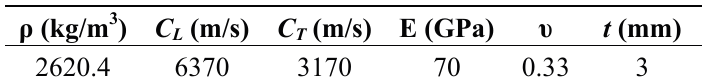
Table 1. Material properties of the plate model: Mass density ( ρ ), longitudinal wave velocity ( C ), shear wave velocity ( C ), Young’s modulus (E), Poisson coefficient ( υ ) and L T the thickness of the plate ( t